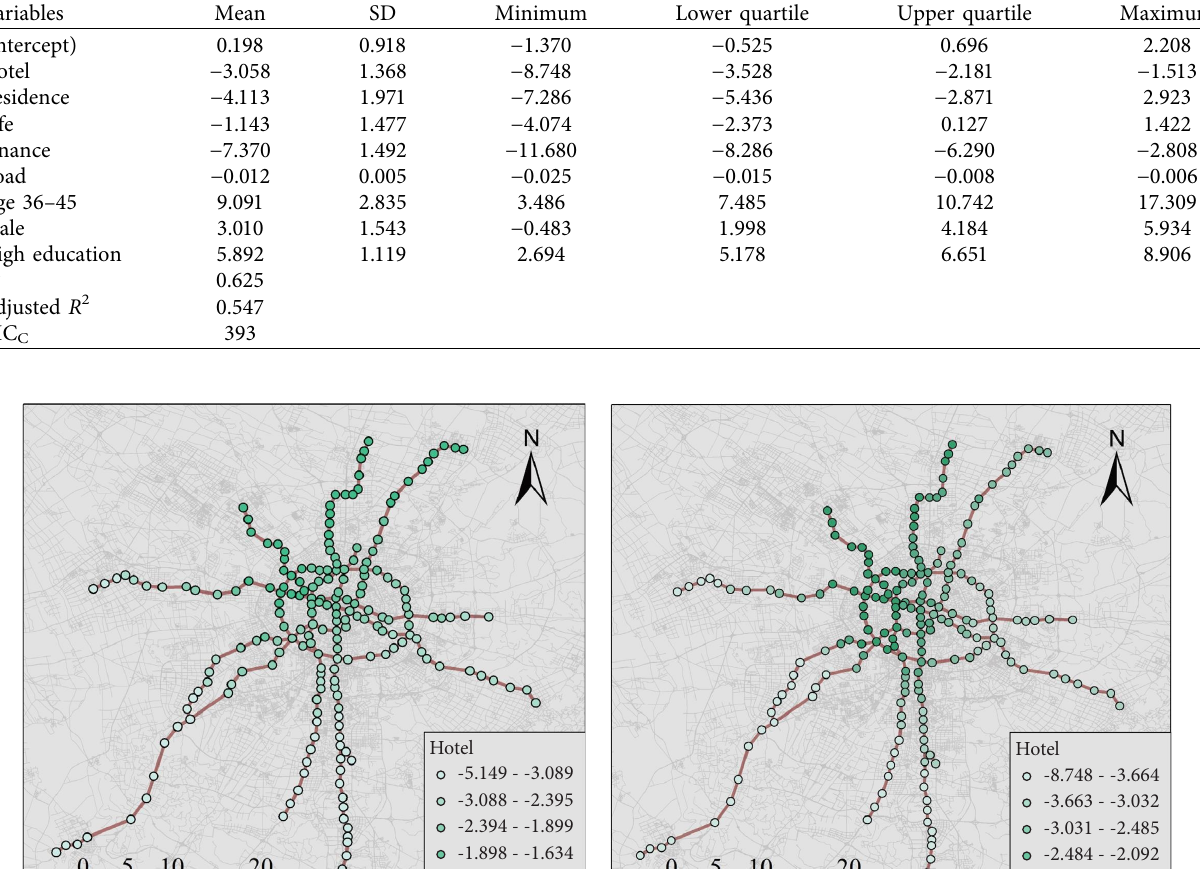
Table 9: Regression results of